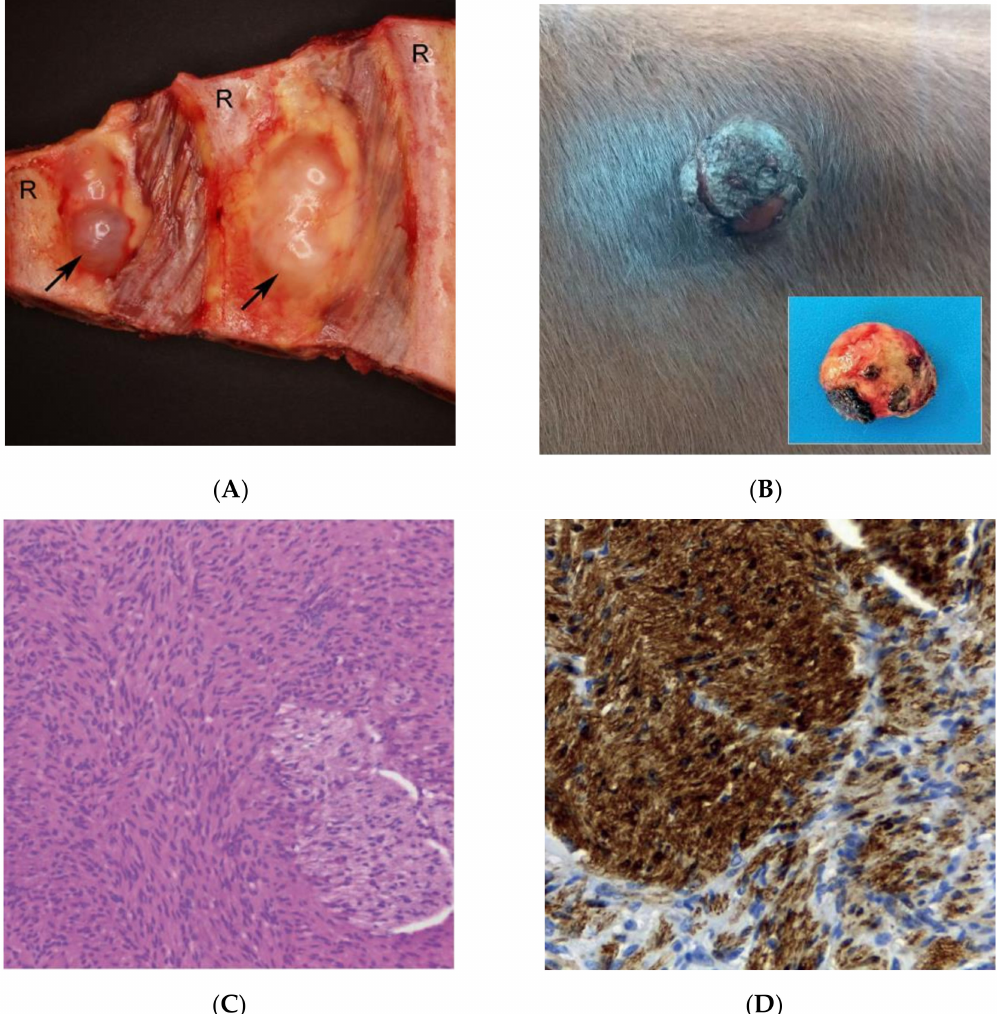
Figure 1. Spontaneous features of neurofibromatosis (NF) in cows. Bovine peripheral nerve sheath tumor (PNST) ( A ) and cutaneous neurofibroma ( B – D ). ( A ) PNST. Two tumors (arrows) located in relation to intercostal nerves (not visible).